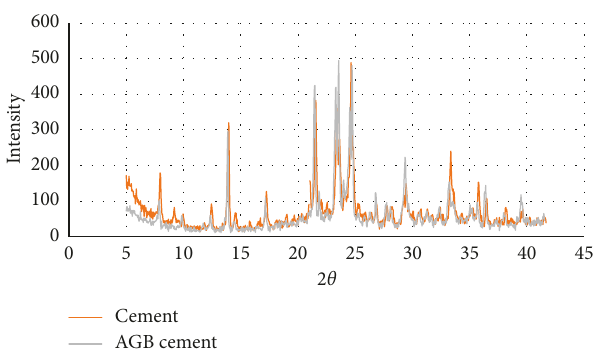
Figure 8: SEM structure of pure cement material.